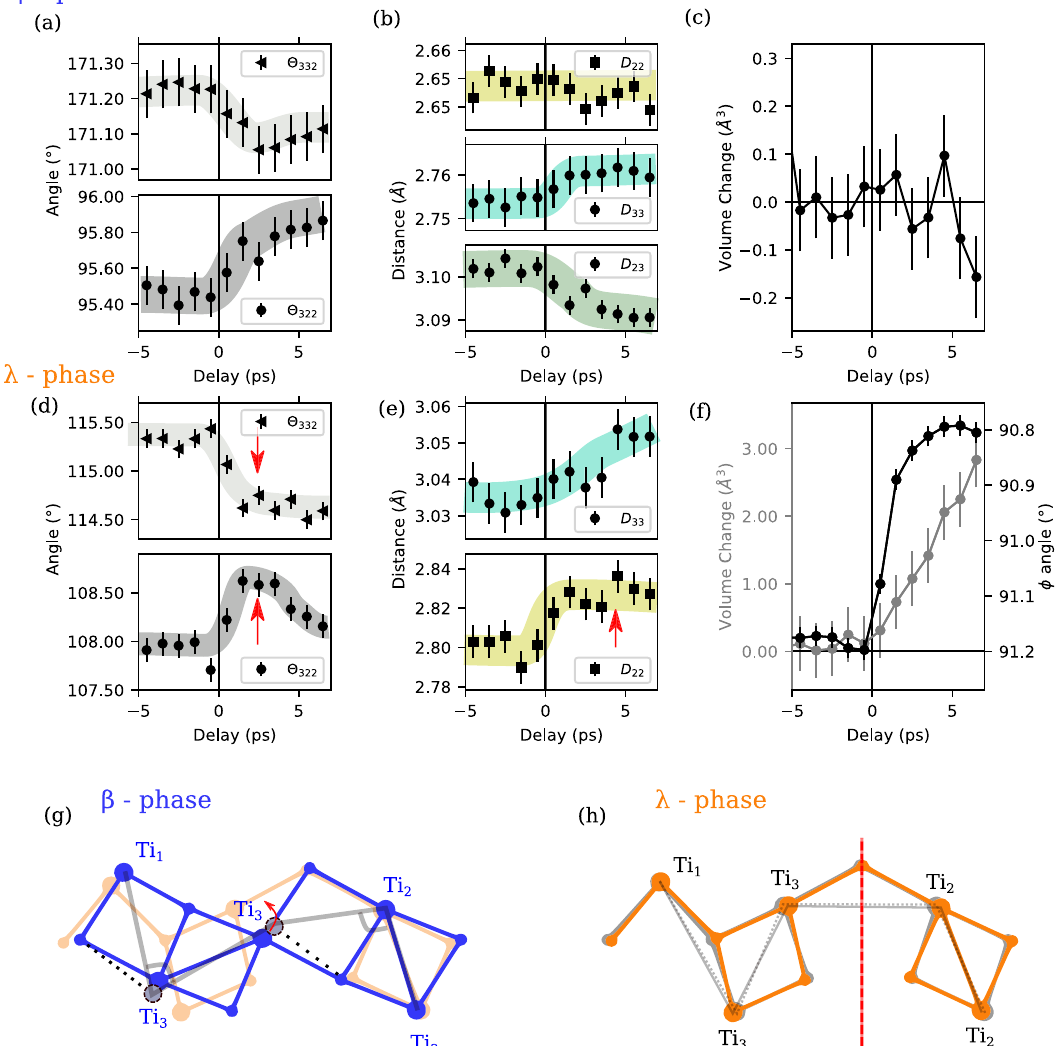
Fig. 3 Ultrafast structural changes inferred by X-ray diffraction. Evolution of important inter-atomic angles, distances, and unit cell volume changes for the β - ( a – c ) and λ - ( d – f ) phases ( ϕ ijk = Ti i -Ti j -Ti k angles and D ij = Ti i -Ti j distances). The evolution of the monoclinic ϕ angle is also reported for the λ - phase ( f ). Thick transparent solid colored lines are guides for the eye. Schematic representation of the observed local distortions (exaggerated for clarity) for the β - ( g ) and λ - ( h ) phases. In ( g ), the λ - structure is represented in light orange for reference and in ( h ), the red line is the m mirror planes lost at T of structural distortion shown in gray contour lines: dotted — before, solid — after